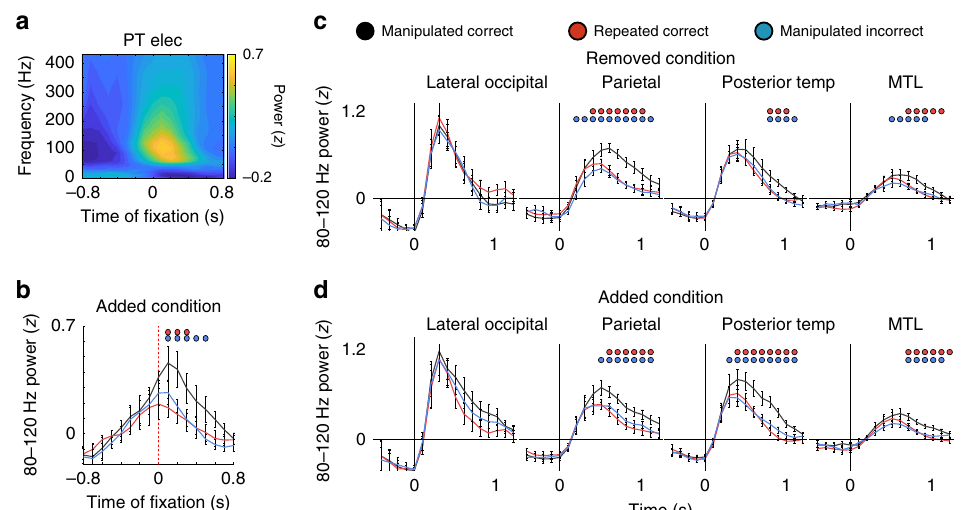
Fig. 4 Increases in 80 – 120 Hz power are locked to eye fi xations and emerge whether an item is added or removed. a Average spectrogram relative to the fi rst fi xation on successfully recognized added items for a representative electrode in PT. b Time courses of 80 – 120 Hz for visually responsive electrodes across participants for the added correct, added incorrect, and repeated correct conditions locked to the fi rst fi xation on the added item (200 ms sliding windows, 50% overlap; eye fi xation at t = 0). Blue and red dots indicate signi fi cant differences in 80 – 120 Hz power between added correct and added incorrect and repeated correct condition across 8 participants, respectively ( p < 0.05, permutation procedure). c Time courses of 80 – 120 Hz power for the removed correct, removed incorrect, and repeated conditions across 6 LOC, 8 PAR, 10 PT, and 10 MTL participants during the recognition period (200 ms sliding windows, 50% overlap; image appears at t = 0). Blue and red dots indicate signi fi cant differences in 80 – 120 Hz power between removed correct and removed incorrect and repeated correct condition, respectively ( p < 0.05, permutation procedure). d Time courses of 80 – 120 Hz power for